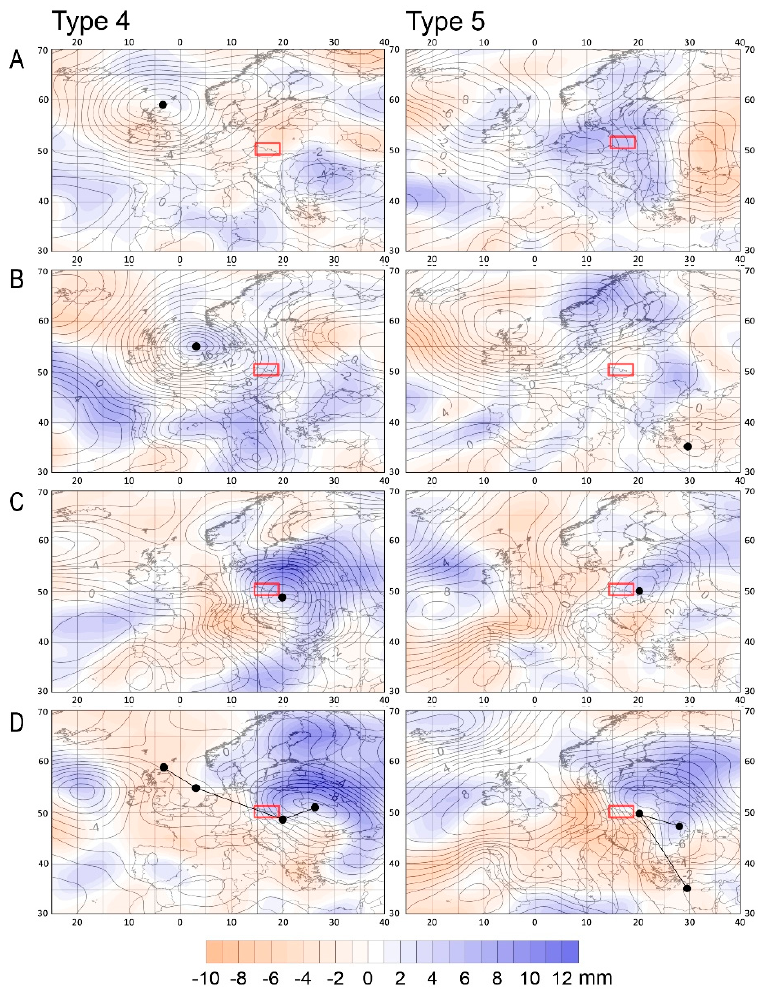
Figure 6. Circulation types 4 and 5 mean SLP (hPa) (solid lines) and PW (mm) (colour scale) anomalies 6 days ( A ), 4 days ( B ), and 2 days ( C ) before the flood culmination and on the flood culmination day ( D ); black dots indicate centers of negative SLP anomalies and in column D cyclone tracks are marked; region of Polish Sudeten Mountains marked as red rectangle.